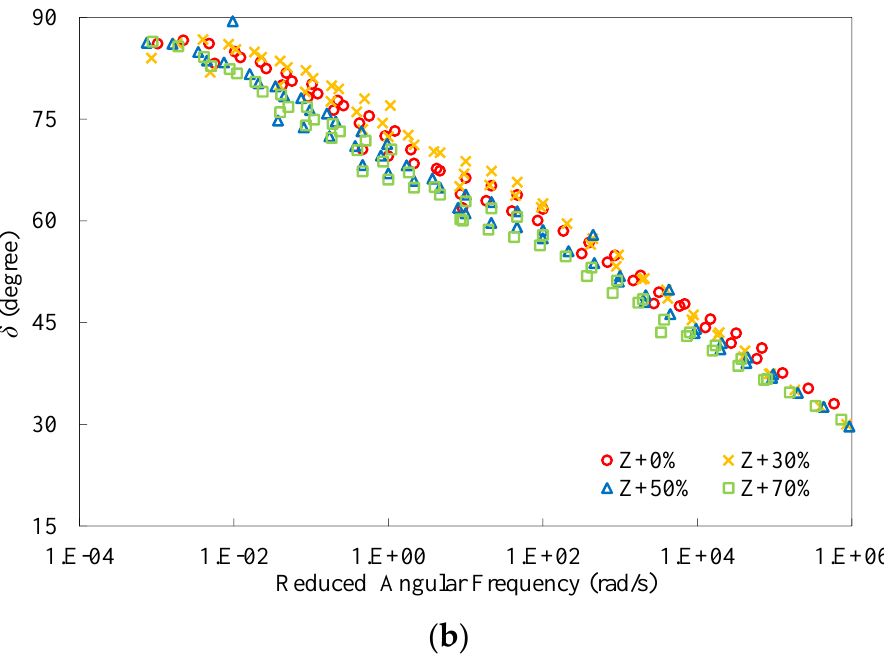
Figure 18. Master curves of dynamic modulus and phase angle of the Z binders at different RAP binder contents.